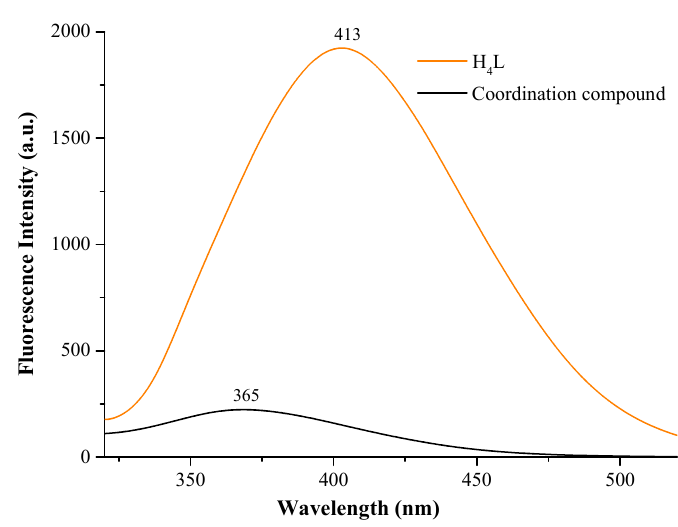
Figure 8. Fluorescence spectra of the ligand H 4 L and its Co(II) coordination compound in the solid state.